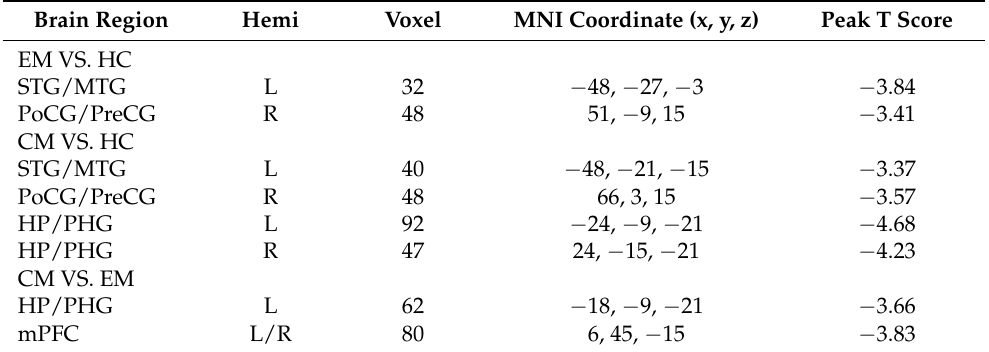
Figure 2. Results of statistical analyses of temporal lag of intrinsic brain activity in the migraine patients and healthy controls. ( a ) Regions showing significant differences in temporal propagation among the three groups include the left STG/MTG, right PoCG/PreCG, bilateral HP/PHG and mPFC. ( b ) Temporal propagation differences between the EM group and HC group. ( c ) Temporal propagation differences between the CM group and HC group. ( d ) Temporal propagation differences between the CM group and EM group. EM, episodic migraine; CM, chronic migraine; HC, healthy control; STG, superior temporal gyrus; MTG, middle temporal gyrus; PoCG, postcentral gyrus; PreCG, precentral gyrus; HP, hippocampus; PHG, parahippocampal gyrus; mPFC, medial prefrontal cortex. Table 3. Brain regions showing significant temporal lag differences between each pair of groups.